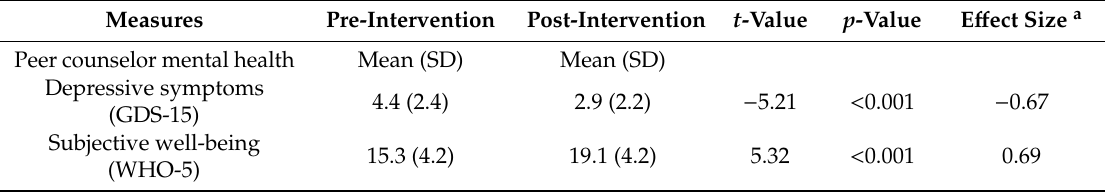
Table 5. Comparison of peer counselors’ pre- and post-intervention mental health status.